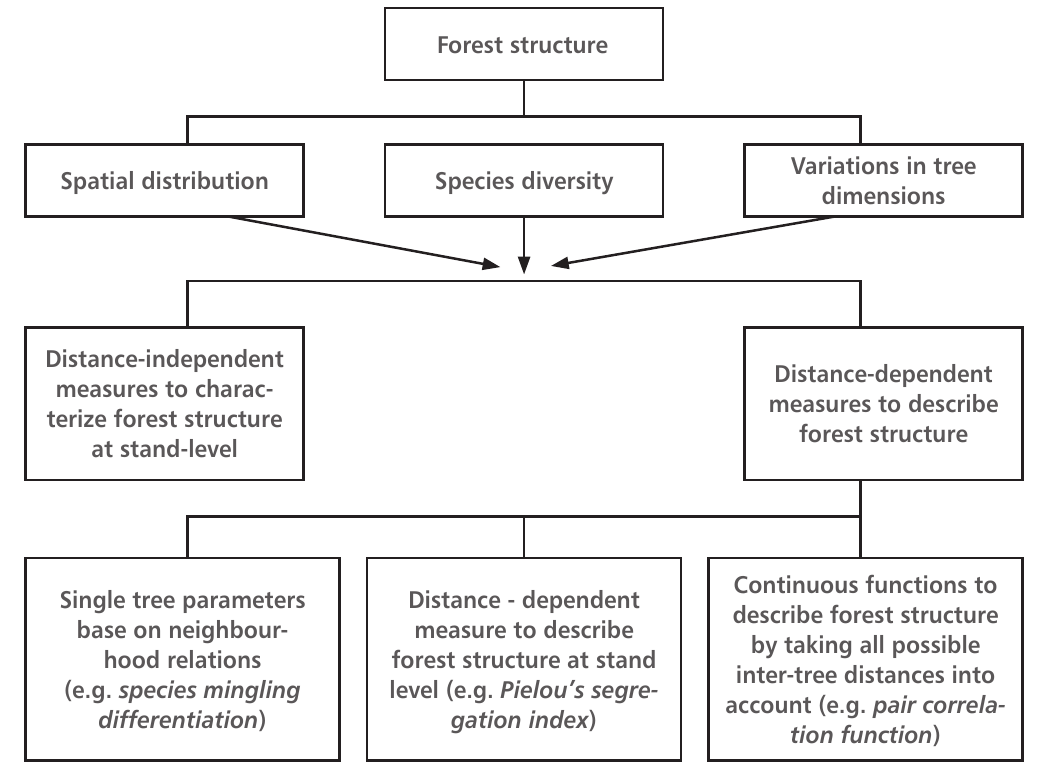
The overview of the three major characteristics of forest structure and the groups of variables by which forest structure was assessed (Pommerening [15] modified from Albert